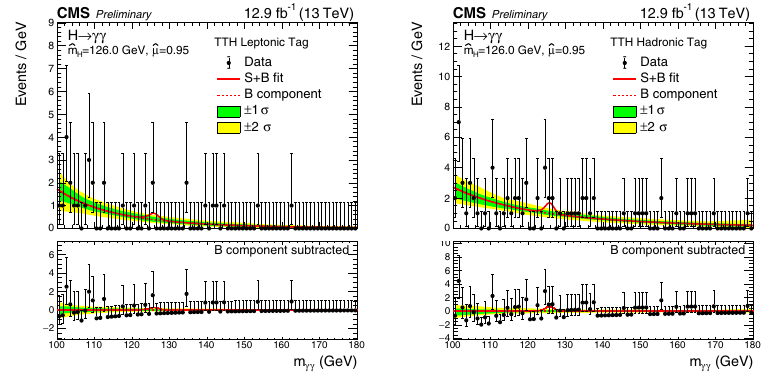
Figure 8. Data points (black) and signal plus background model fits t¯tH category is shown [6]. The one standard deviation (green) and two standard deviation bands (yellow) include the uncertainties of the fit. The bottom plots show the residuals after background subtraction.